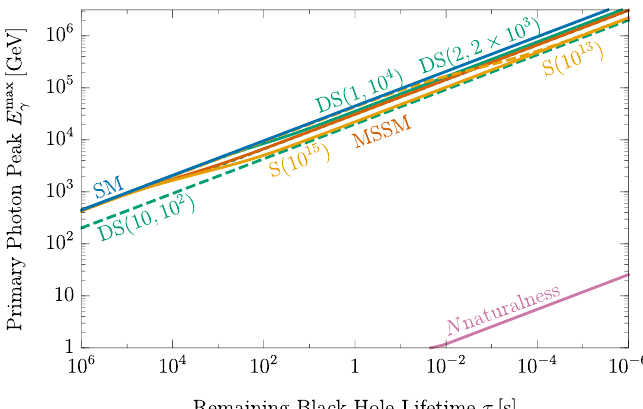
Figure 4 . The peak energy of the primary photons as a function of the remaining black hole life time for our benchmark